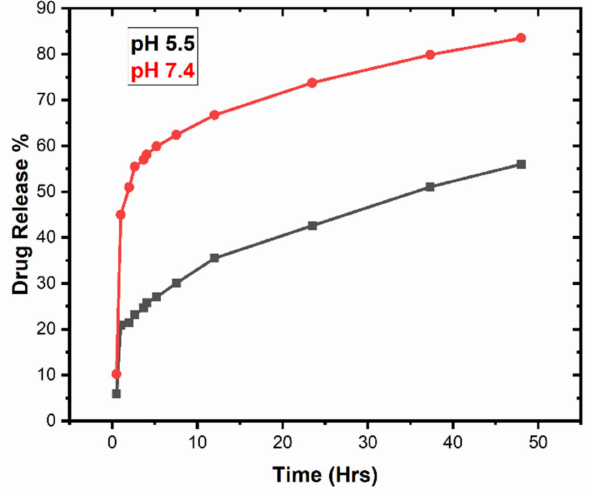
Figure 8. In vitro drug release profile from polymeric nanoparticles at pH 5.5 and pH